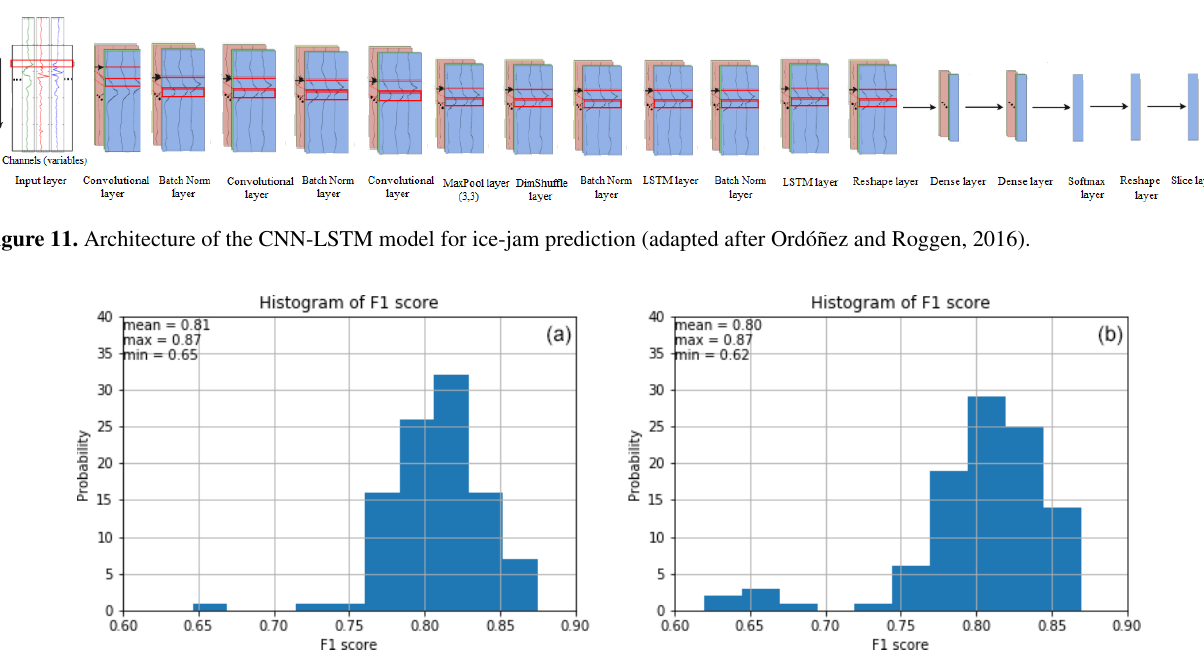
Figure 12. Histograms of F1 score for CNN using He (a) and Glorot uniform (b) weight initialization with 100 random training–validation